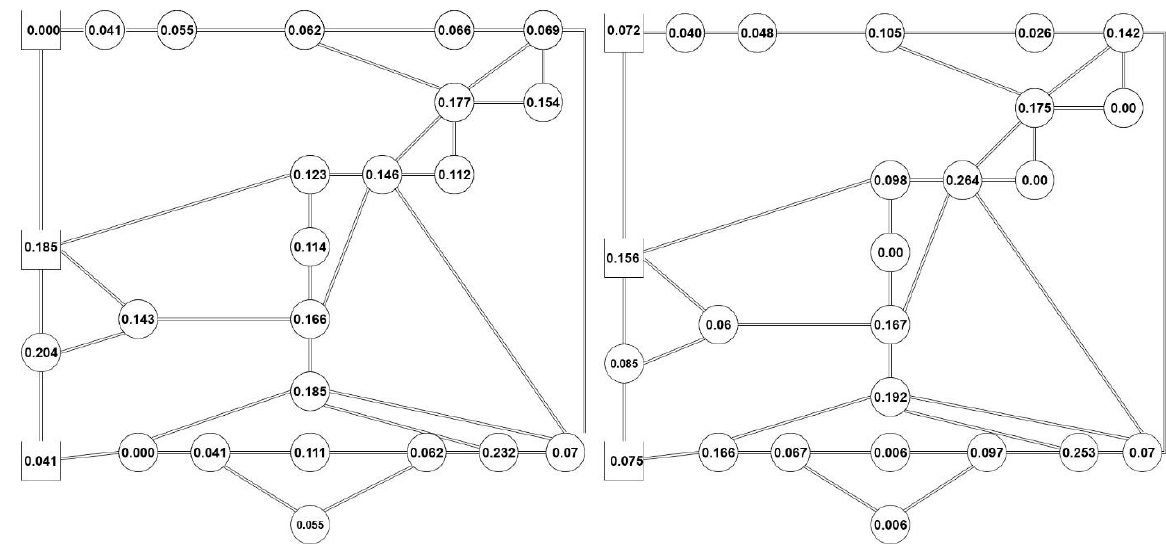
Figure 4. Closeness centrality ( left ) and betweenness centrality ( right ).